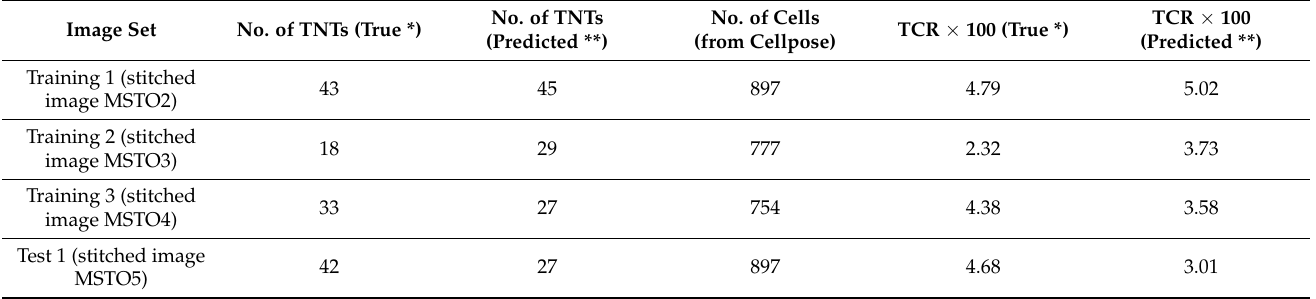
Table 2. Results reporting the tunneling nanotube (TNT)-to-cell ratio (TCR, or TNT index). * True, identified by human experts. ** Predicted, detected by the